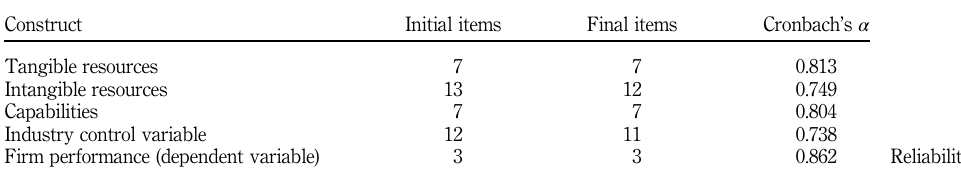
Table V. Reliability